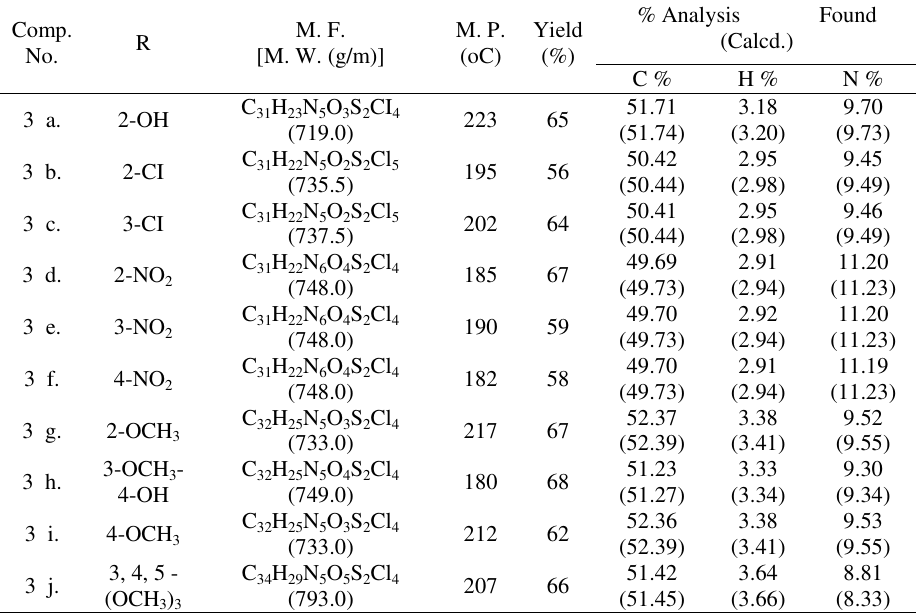
Table 3 . PHYSICAL AND ANALYTICAL DATA OF COMPOUNDS [3(a-j)]